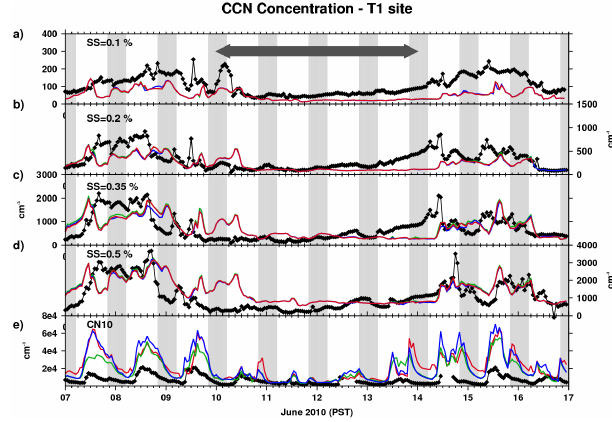
Figure 21. Same as Fig. 20, except for the T1